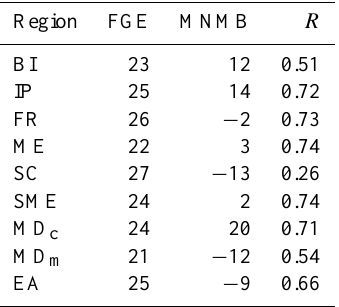
Table 2. Annual statistics of near-surface ozone for the MACC re- analysis (2003–2012) over the different European subregions. FGE and MNMB are expressed in %.